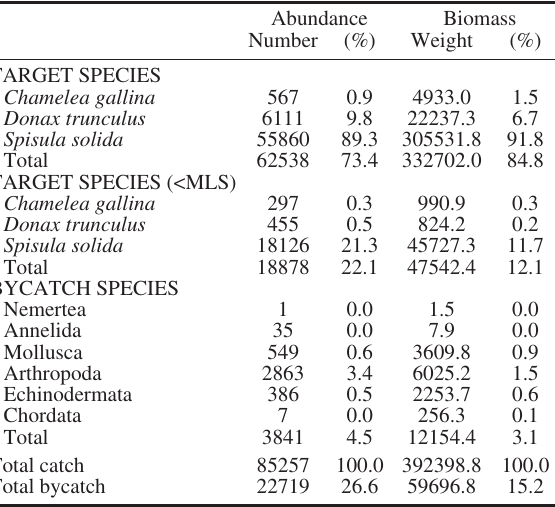
Table 2. – Total abundance (number of individuals) and biomass (g) of the target species, undersized target species (<MLS) and bycatch species caught using two types of bivalve dredge (SDredge and Ddredge) in the fishing surveys performed along the Algarve coast (southern Portugal).